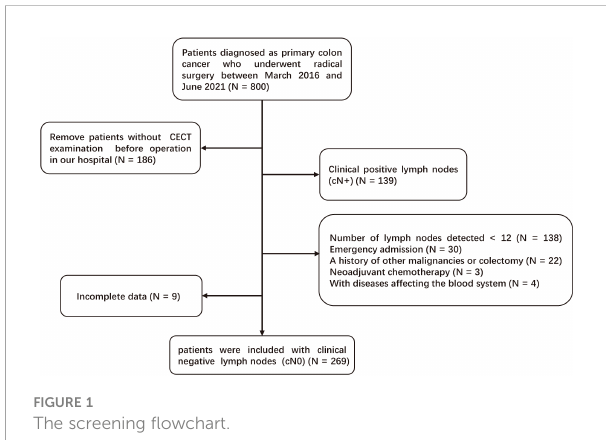
FIGURE 1 The screening fl